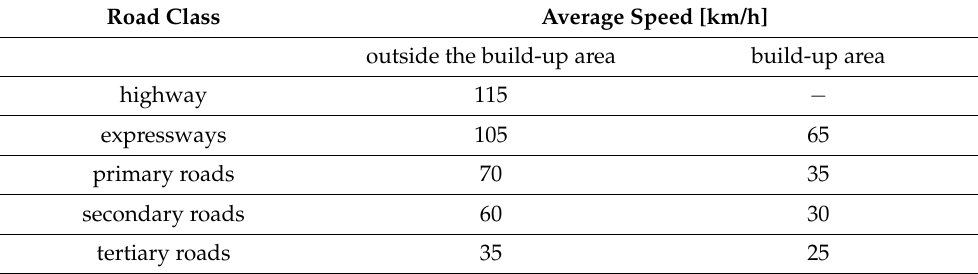
Table 2. Average speed on different types of